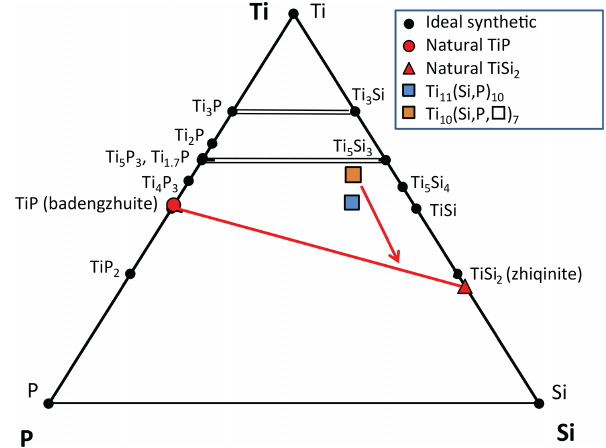
Figure 9. Plot of compounds in the ternary Ti–Si–P system in foil no. 5358. Data on the natural phases are averages of two to four EDX analyses. Source of data: badengzhuite and zhiqinite (Tables 2 and 3); Ti 10 (Si,P, (cid:3) ) 7 and Ti 11 (Si,P ) 10 (F. Xiong et al., unpublished data). Synthetic Ti–P phases are from Okamoto (2007); synthetic Ti–Si phases are from Fiore et al. (2016). Dashed brown lines: pos- sible solid solution between isostructural Si and P phases. Solid red line: tie line for foil no. 5358. Red arrow shows inferred crystal- lization sequence for the ternary melt yielding the spheroid in foil no.